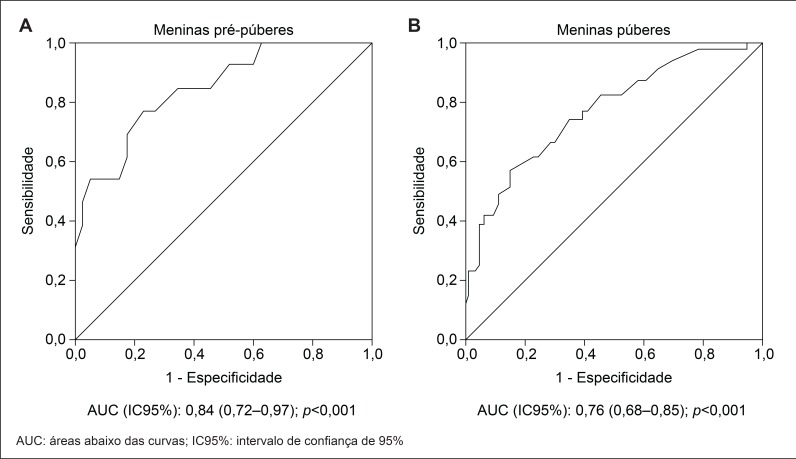
Curva ROC para a circunferência do pescoço na avaliação da resistência à
insulina em adolescentes do sexo feminino pré-púberes (A) e púberes
(B)